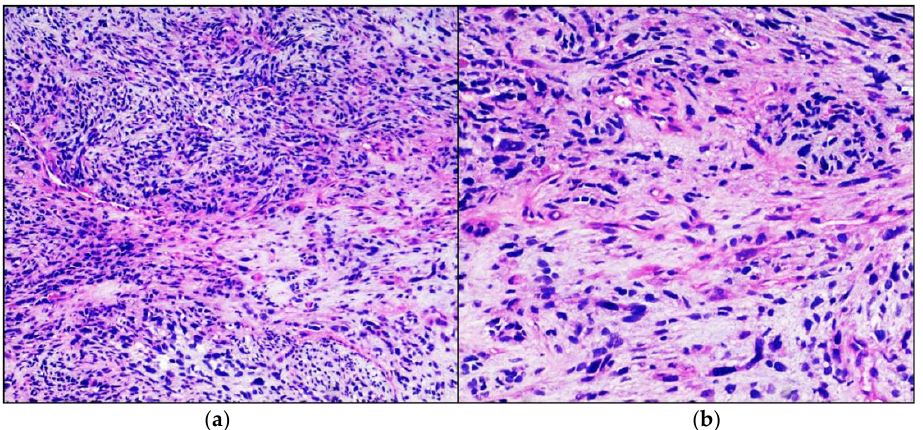
Figure 1. Embrional Rhabdomyosarcoma. Hematoxylin-eosin stained photomicrographs, with original magnification 100× ( a ) and 200× ( b ), showing characteristic intersecting fascicle of spindle cells with eosinophilic cytoplasm and iperchromic pleomorphic nuclei.